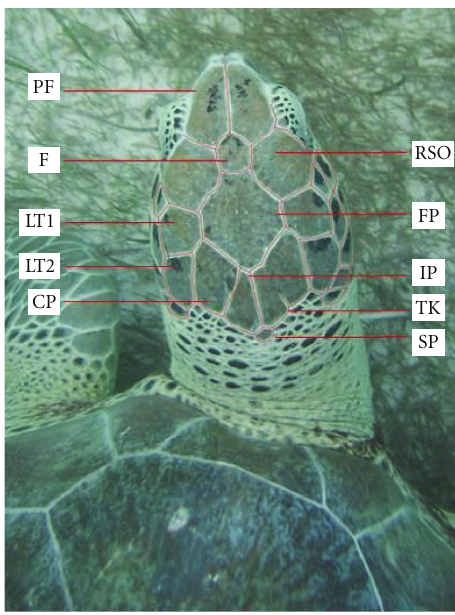
Figure 1: Key diagnostic features used to distinguish individual turtles from photographs of their heads. Refer to Table 1 for further details of